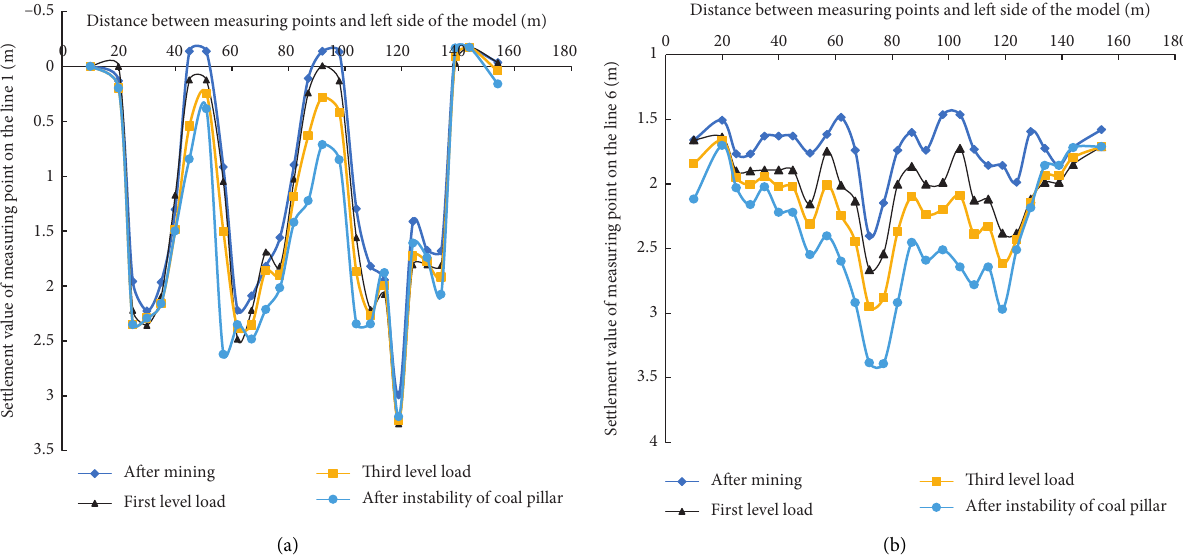
Figure 13: (a) Settlement curve of survey line 1 of the bedrock at different stages; (b) settlement curve of survey line 6 of the loose layer at different stages.